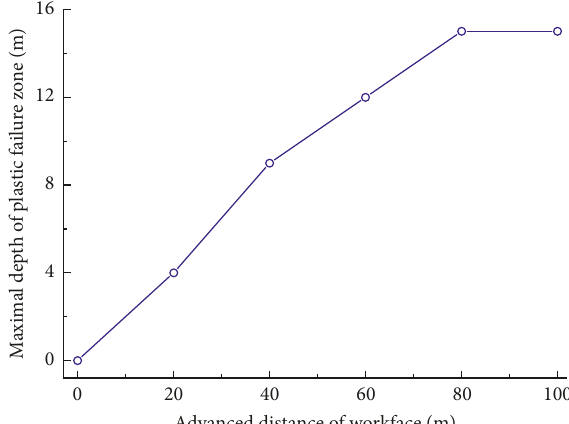
Figure 5: Maximal plastic failure depth of workface floor along the inclined direction of coal seam with the advancement of